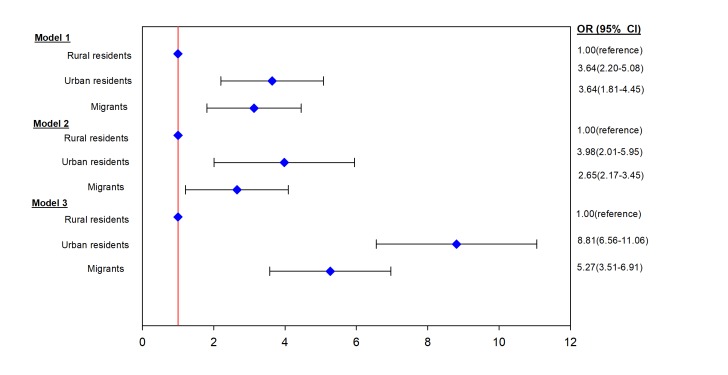
Odds of type 2 diabetes in underweight/normal weight urban residents and migrants, compared to rural – Ghanaians. Data are odds ratio (95% Confidence Interval). Model 1 – adjusted for age, sex and education. Model 2 – Model 1 with further adjustment for alcohol consumption, smoking, physical activity, hypercholesterolemia, hypertension and length of stay in the migrants. Model 3 – Model 2 with further adjustment for blood glucose control (HbA1c <7% (53 mmol/mol)) and diabetes treatment (diet, oral medication and insulin use).